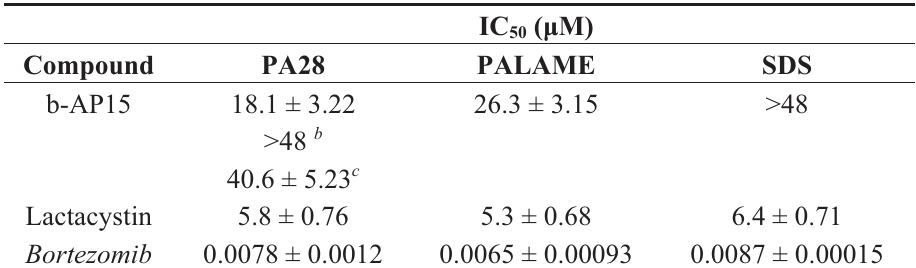
Table 1. Inhibitory effect of b-AP15 on the 20S proteasome a